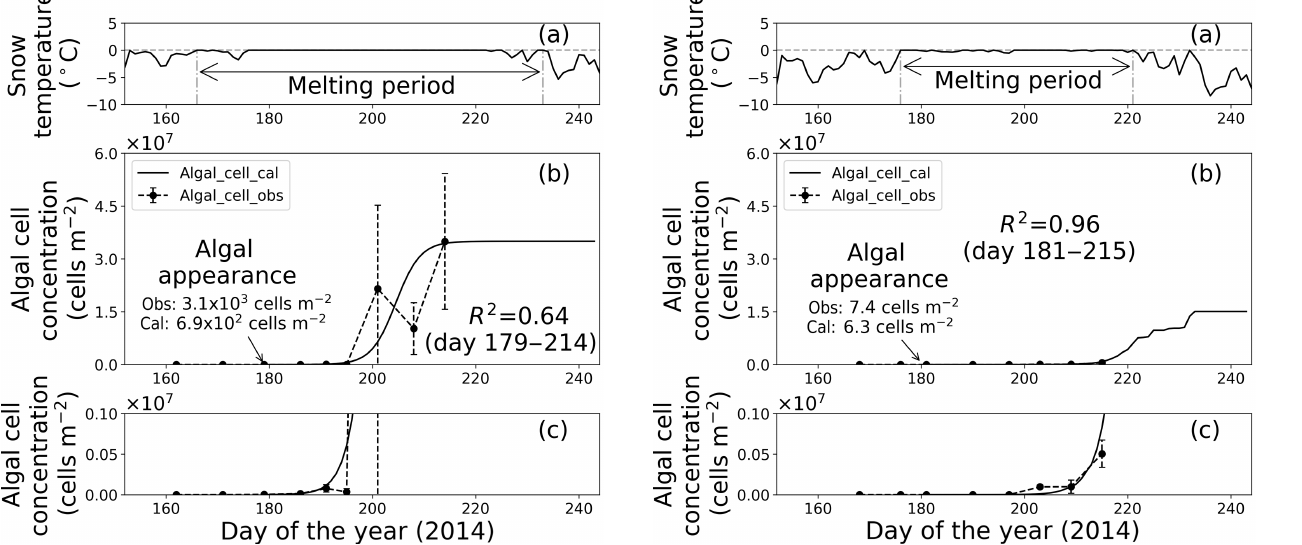
Figure 7. Temporal changes in snow temperature and algal abun- dance on the surface at Site A. (a) Mean daily snow surface temper- ature, (b) observed and calculated algal abundance, and (c) enlarge- ment of the observed and calculated algal abundance between 0 and 1.0 × 10 6 cellsm − 2 . Surface snow temperature was calculated from observed downward and upward long-wave radiant fluxes. Solid marks indicate observed algal abundance. Solid lines indicate algal abundance calculated from regression by logistic model. Standard deviation shown by error bars.